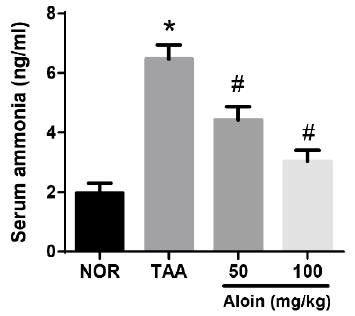
Figure 3. Effect of aloin on serum ammonia levels. Values in the bar graphs represent the mean ± SEM, n = 7. * p < 0.05 vs. normal control rats, # p < 0.05 vs. TAA-injected rats.